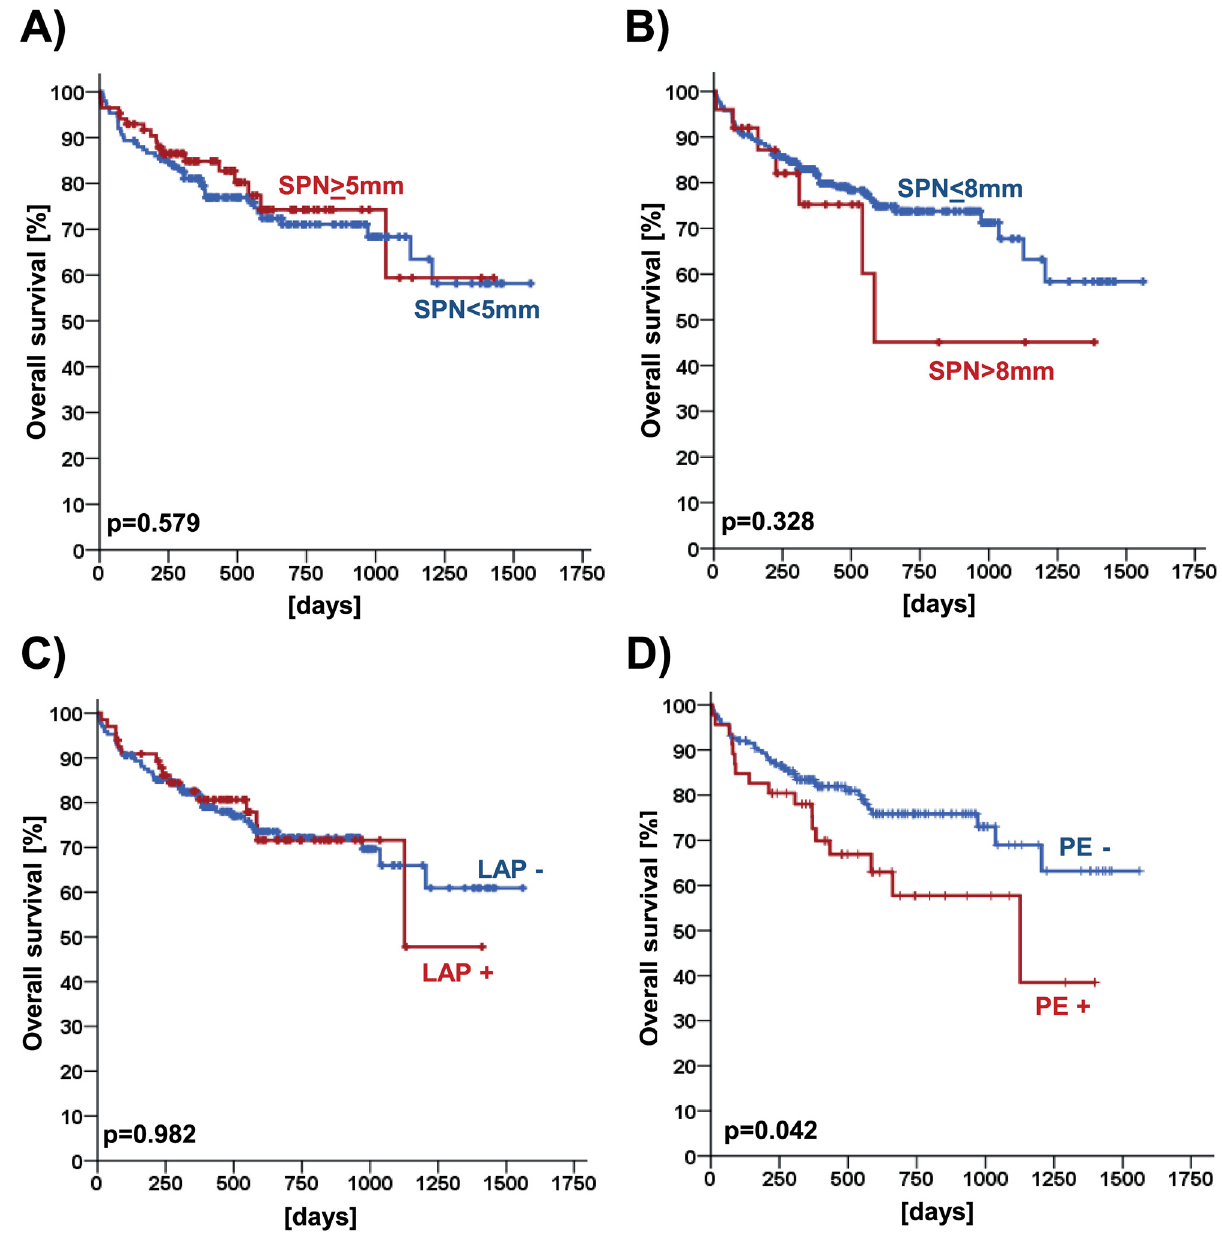
Fig 3. Prognostic impact of solitary pulmonary nodules (SPN), lymphadenopathy (LAP) and pleural effusions (PE) in patients under evaluation for TAVI (n = 237 patients). Kaplan Meier charts are given for SPN (cid:1) 5mm ( A ), for SPN > 8mm ( B ), for LAP ( C ) and for PE ( D